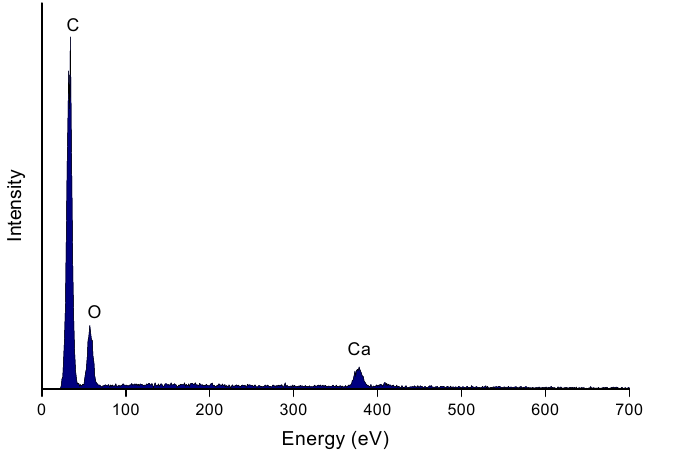
Figure 3. EDS spectra for functionalized reduced graphene oxide (rGO-CP).